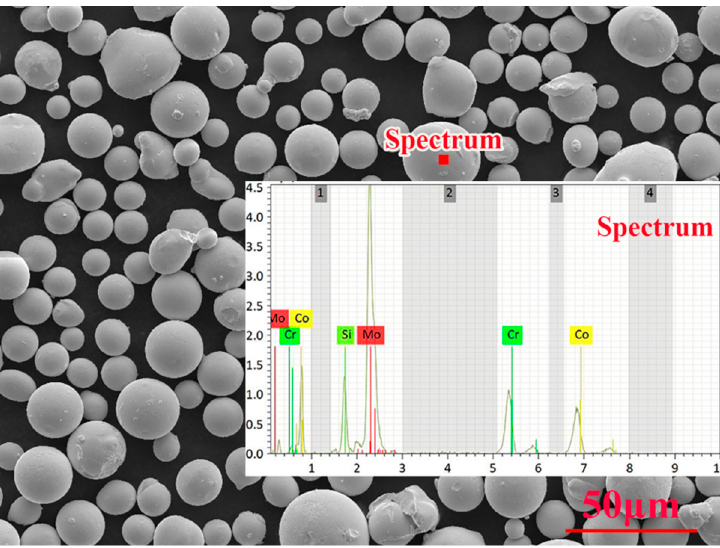
Figure 1. Surface morphology and EDS result of the CoMoCrSi powder. Table 1. Chemical composition of CoMoCrSi coating and 316L steel.